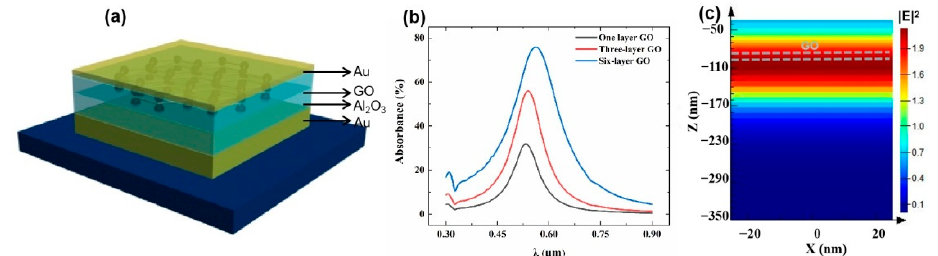
Figure 1. ( a ) The 3D schematic diagram of the GO integrated nanocavity. ( b ) The simulated ab- sorption spectra of the device with different layers of GO by Lumerical FDTD. ( c ) The electric field distribution of the GO integrated cavity at the maximum absorption wavelength of 532 nm.